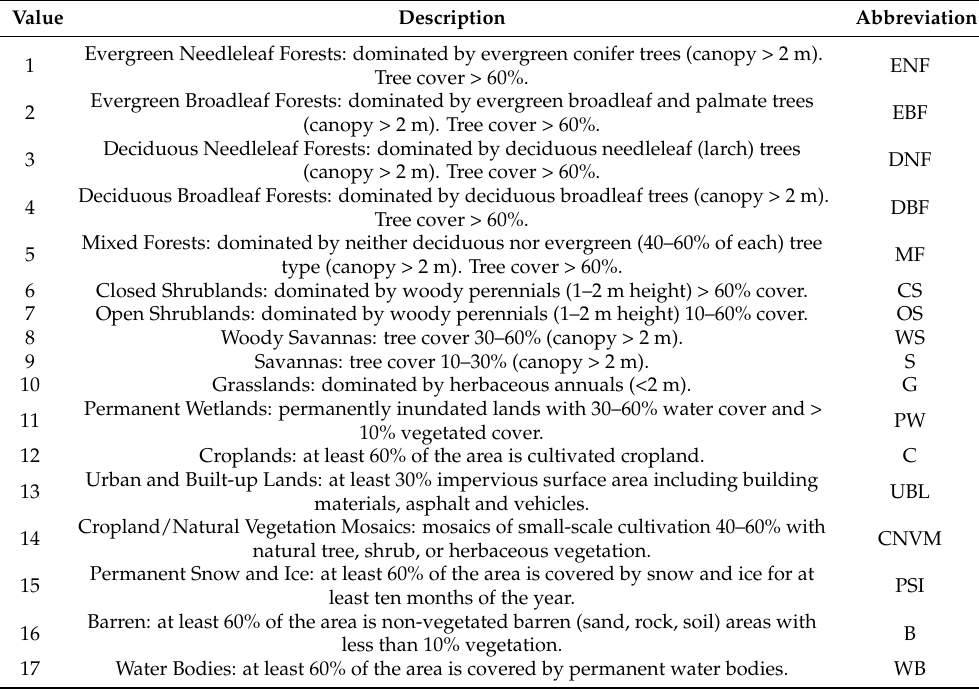
Figure A3. The proportions ( a ) and mean annual growth rates ( b ) of different land cover types in the YRB. The four different land cover types are Grasslands (G), Croplands (C), Deciduous Broadleaf Forests (DBF), and Barren (B). Table A1. Land cover types, following the Annual International Geosphere–Biosphere Programme (IGBP)